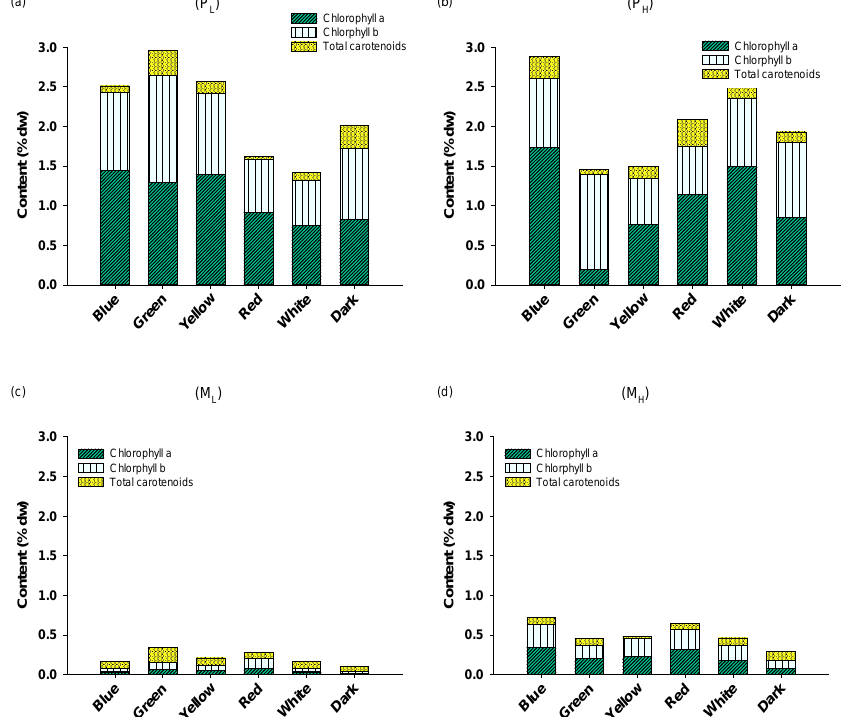
Figure 4. Pigments content of A. protothecoides cultivated in different light wavelengths under photoautotrophic conditions with ( a ) low peptone and ( b ) high peptone concentration, and in mixotrophic conditions with ( c ) low peptone and ( d ) high peptone concentration. Each bar represents the average of n = 3 replicates.